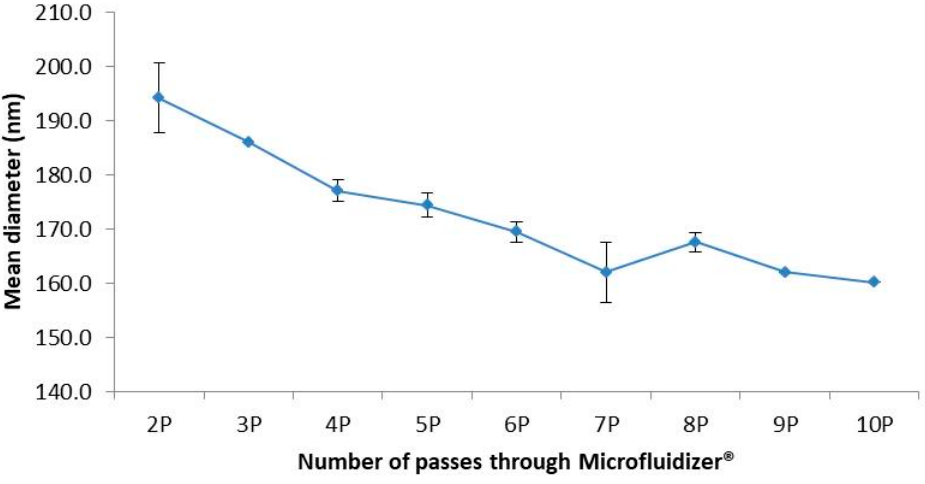
Figure 2. Optimization of the number of passes through Microfluidizer ® .